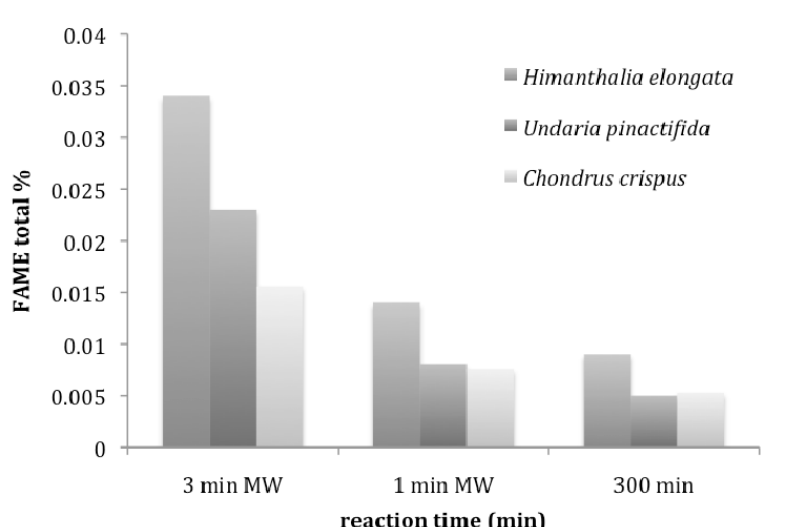
Figure 5. Effect of reaction